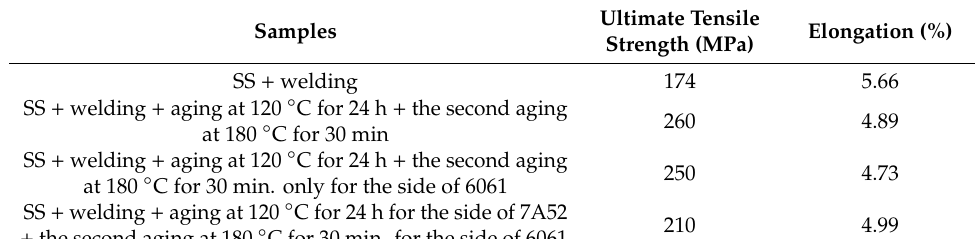
Table 2. Tensile properties of the weld.